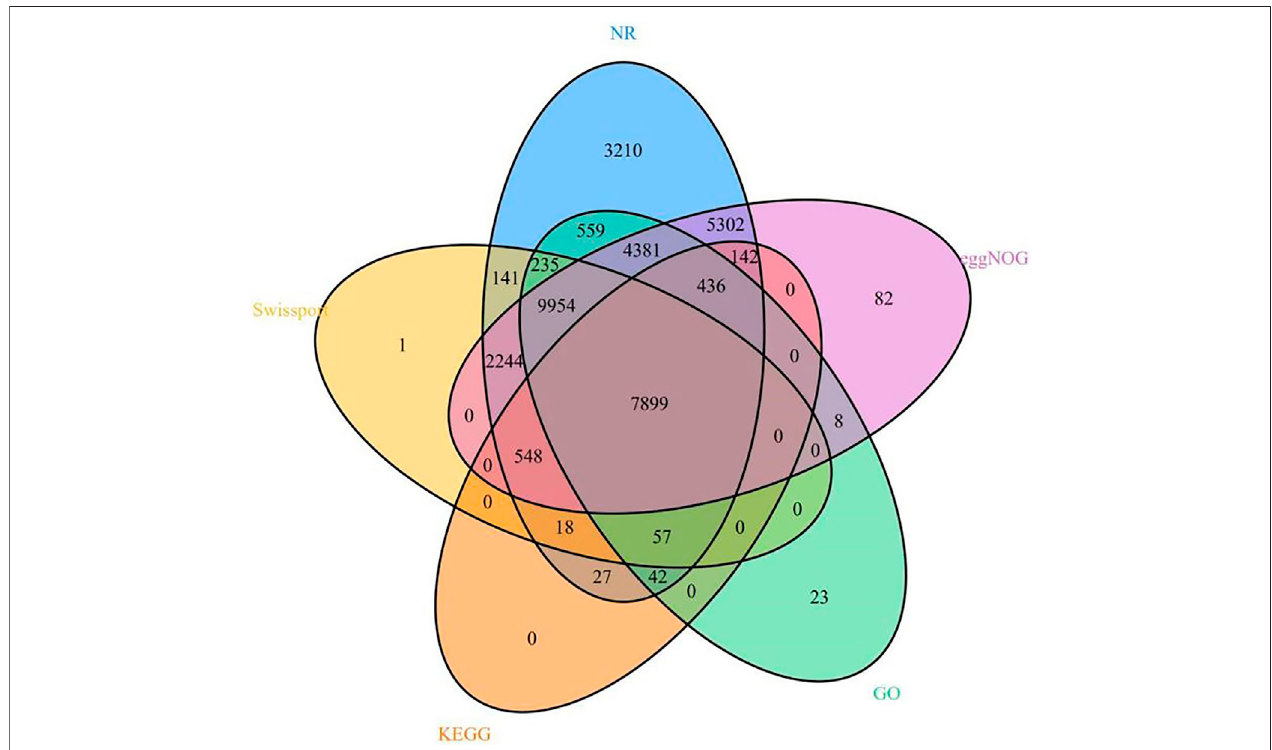
FIGURE 3 | A Venn analysis of gene function